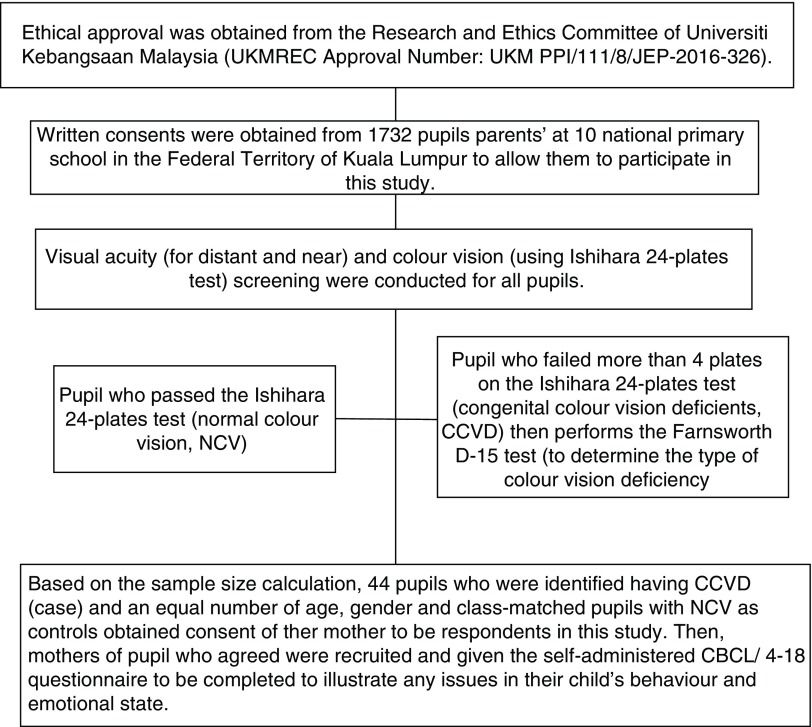
Flow diagram of participant recruitment procedure.